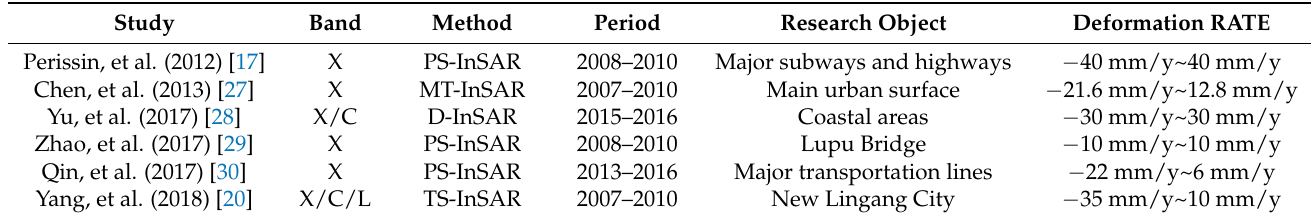
Table 2. Summary of the previous studies of land subsidence in